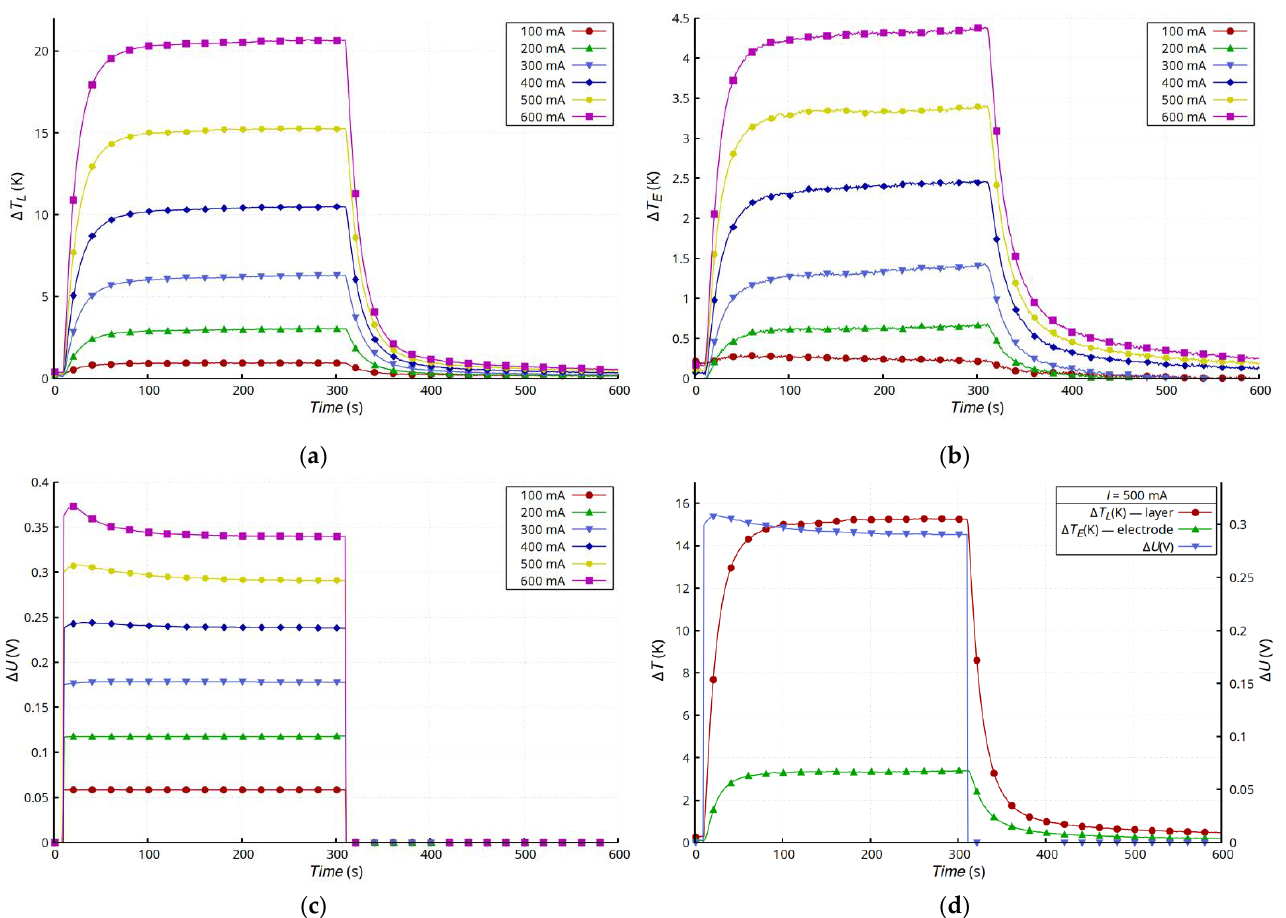
Figure 5. Results for G + T sample: time dependence of changes in temperature of Ag layer Δ T L ( a ), changes in temperature of electrode Δ T E ( b ), and drop voltage on sample Δ U ( c ), as well as comparison of results for I = 500 mA ( d ).